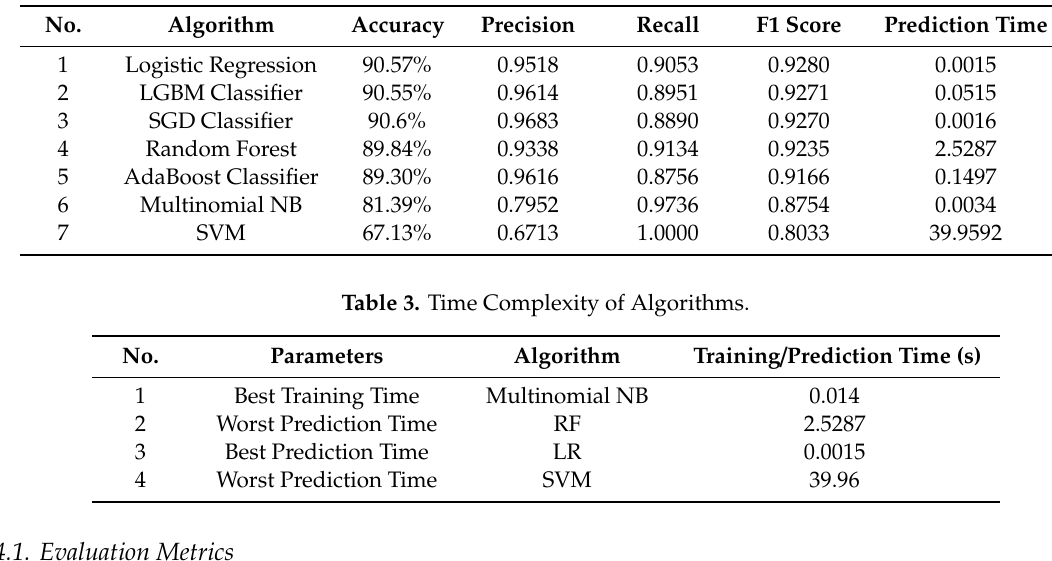
Table 2. Performance Summary of Algorithms.